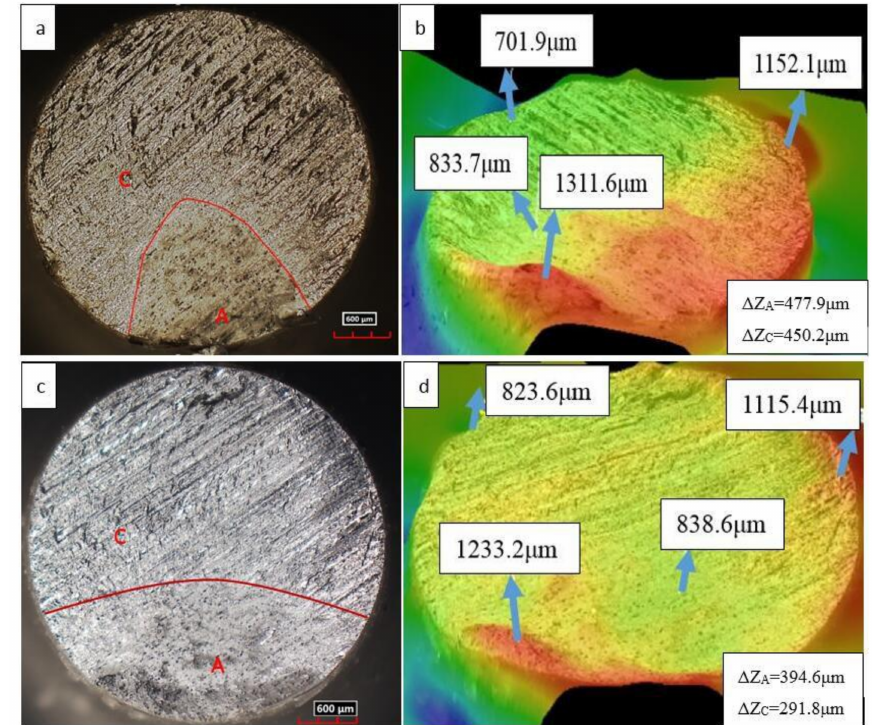
Figure 3. Fatigue fracture surface for the coated ( h = 10 µ m) sample. ( a ) Macro-scale view of N f = 1.835 × 10 5 , σ = 147.0 MPa in air; ( b ) Three-dimensional view of N f = 1.835 × 10 5 , σ = 147.0 MPa in air; ( c ) Macro-scale view of N f = 7.661 × 10 5 , σ = 113.3 MPa in 5.0% NaCl; ( d ) Three-dimensional view of